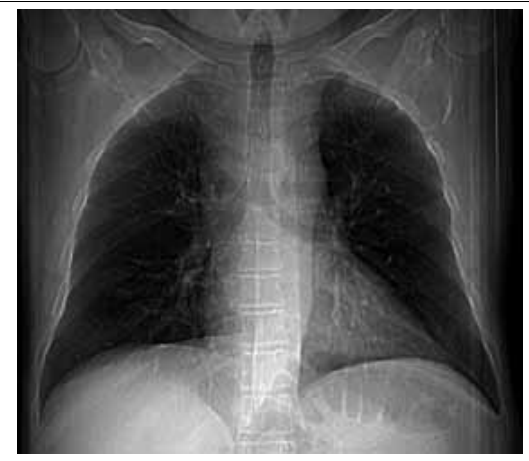
figurE 1 – IPH: posteroanterior chest radiographs demonstrate bilateral areas of consolidation due to pulmonary hemo rrhage IPH: idiopathic pulmonary